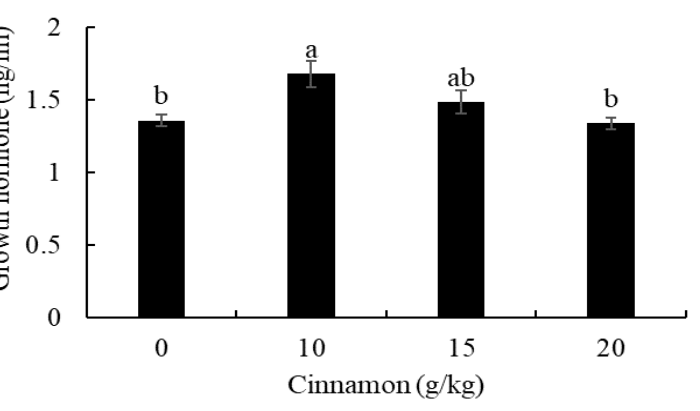
Figure 1. Blood growth hormone levels of European sea bass fed dietary cinnamon. Bars with different letters are significantly different ( p <